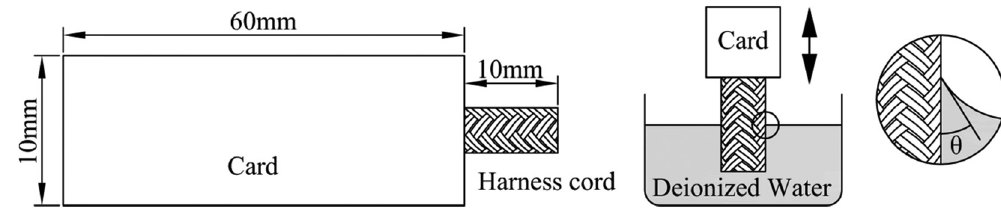
Figure 3: Test specimen and schematic diagram of DCA.